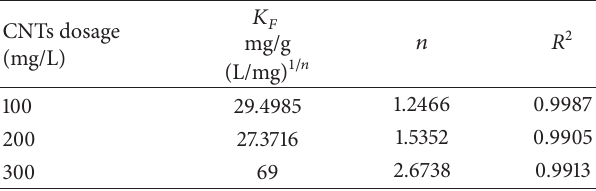
Table 2: Adsorption isotherm constants of Freundlich model for basic orange dye (pH = 8.5 and contact time = 30 min).